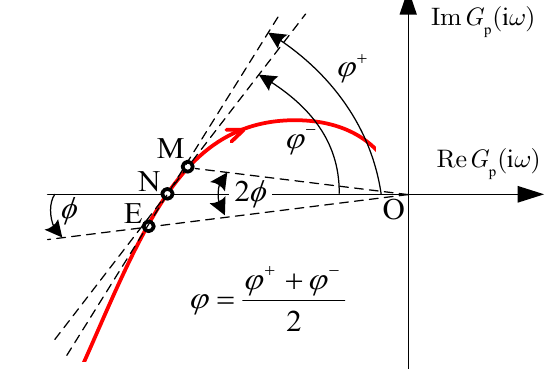
Figure 4 – Modified PLL closed-loop (PLL-CL) structure used for a robust identification of the process G p ( s ) in Fig.